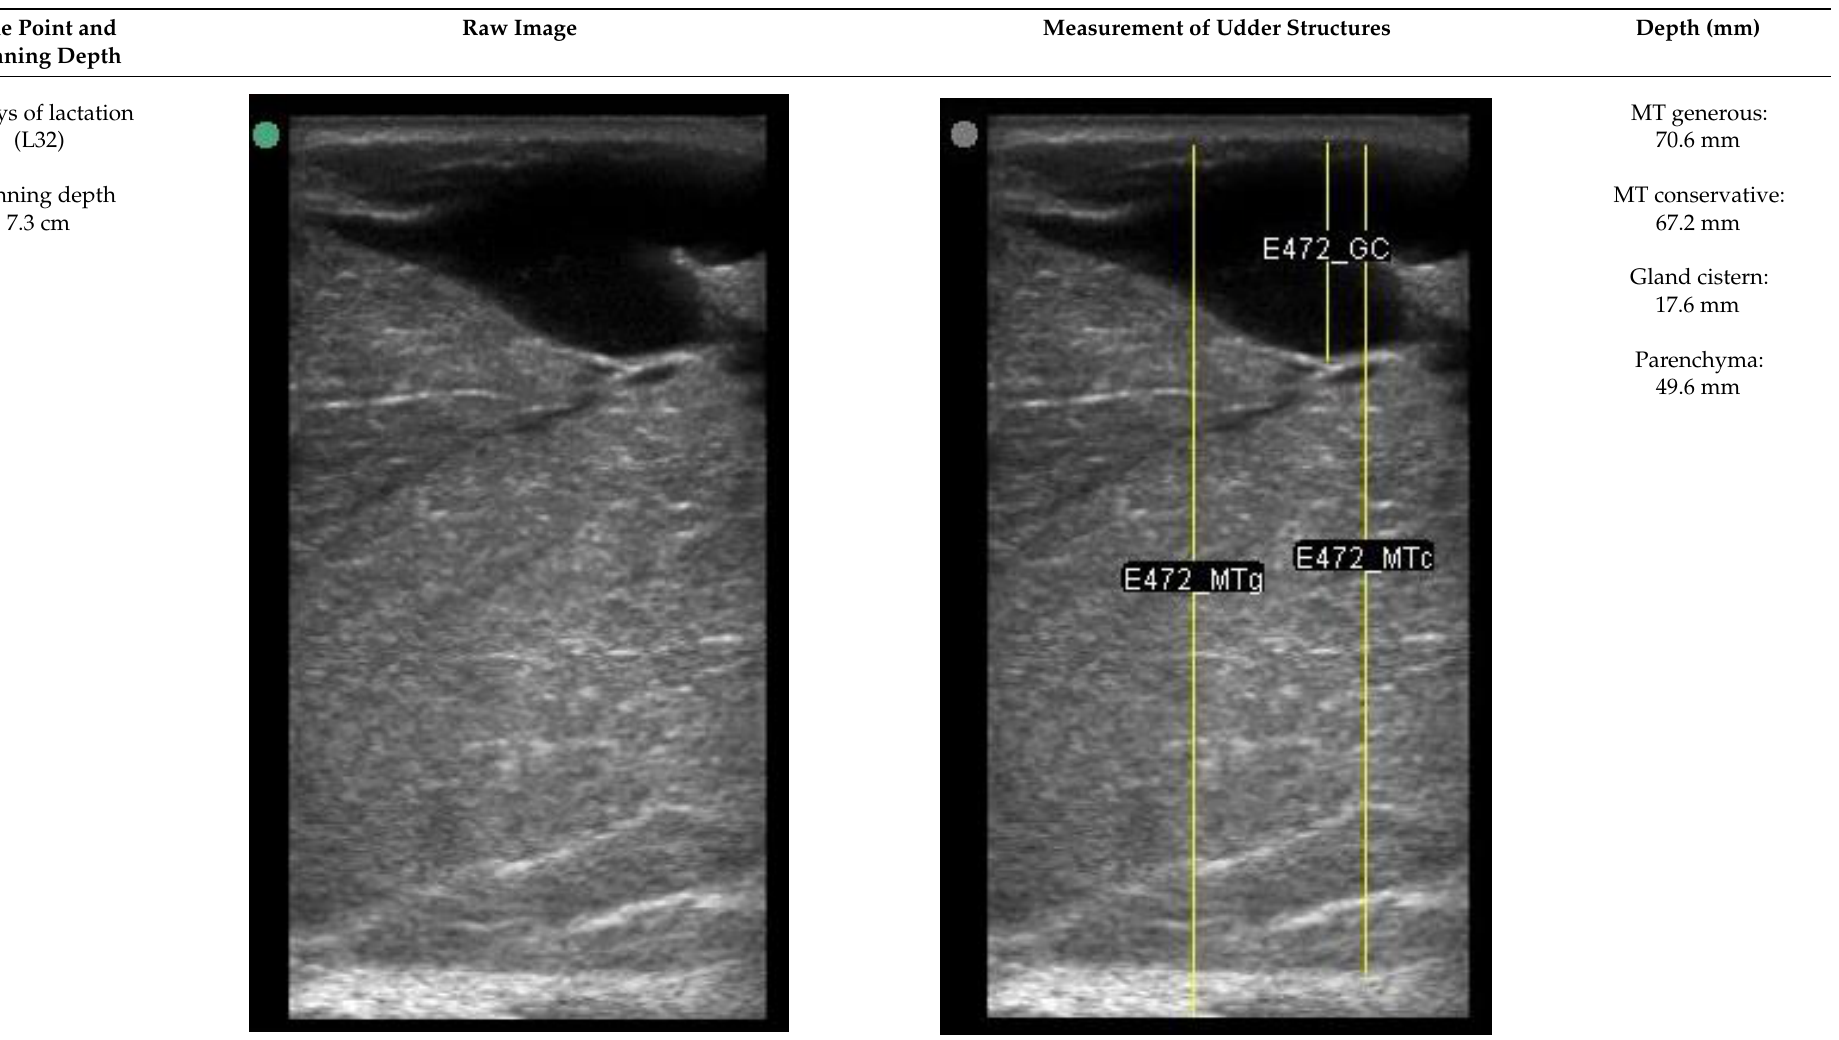
Table A2. Drawing template of mammary ultrasound images in early lactation (29 days of lactation; L29) in four different yearling